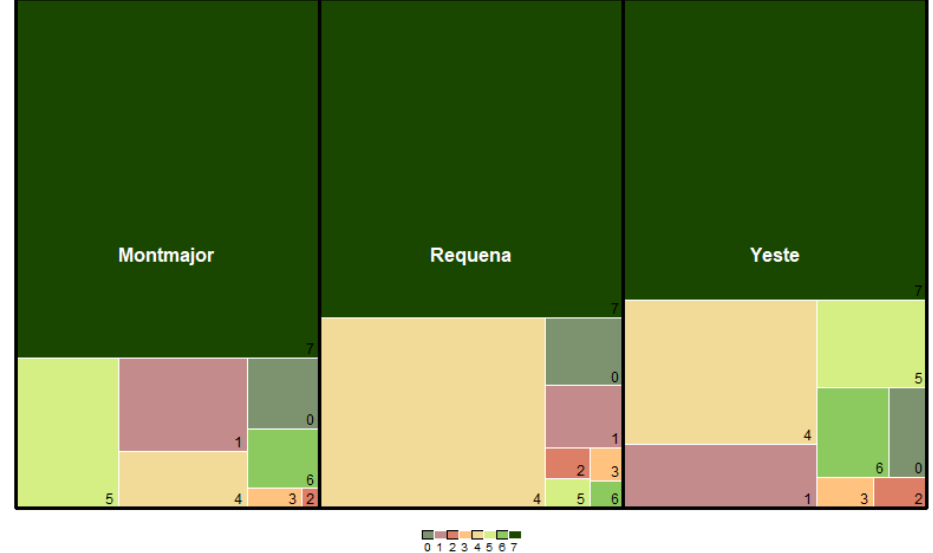
Figure 2. Relative presence of fuel types for the different forested areas under study. The value 0 refers to bare soil, and the values 1 to 7 stands for the Prometheus fuel types.